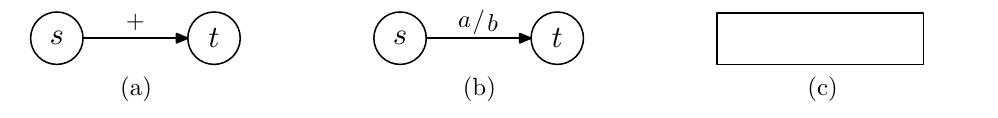
Fig. 1: (a): Instruction δ ( s, / ) = ( t, +). (b): Instruction δ ( s, a ) = ( t, b ). (c):